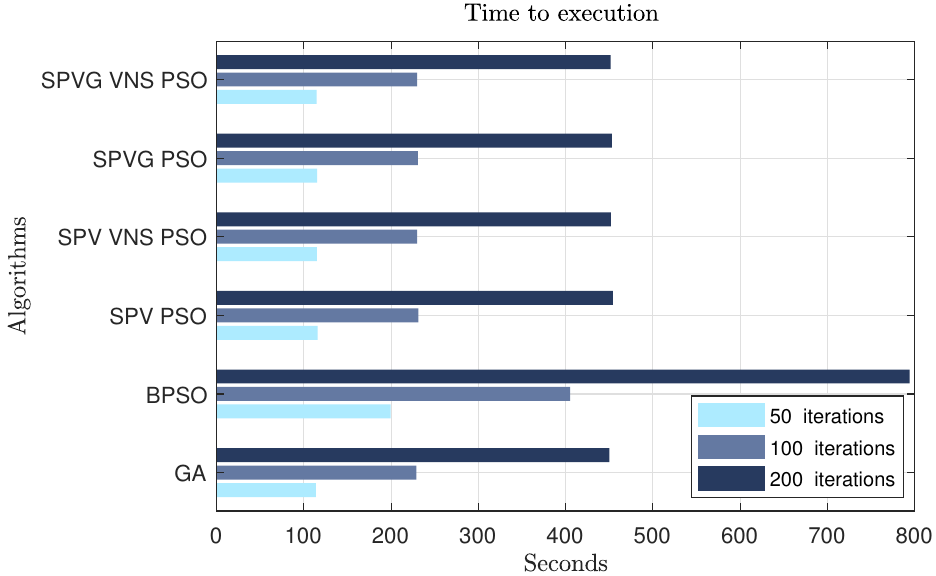
Figure 3. Time to complete the execution of a single instance in the dataset by each algorithm. We used a Google Cloud solution with 32 virtual CPUs, 32GB of RAM, running MATLAB on Ubuntu